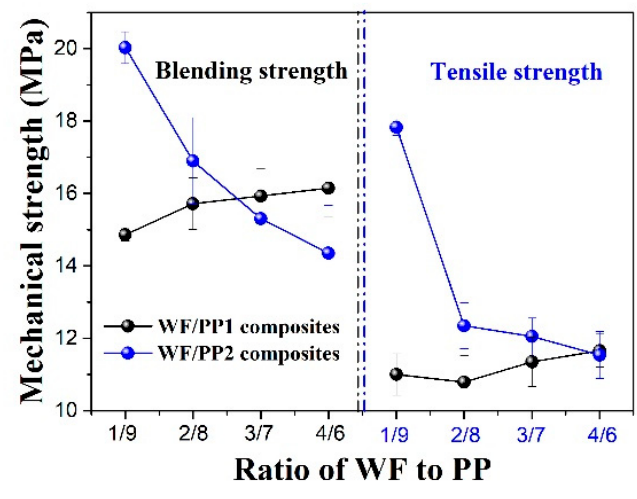
Figure 9. Blending strength and tensile strength of composites with different resin matrix.